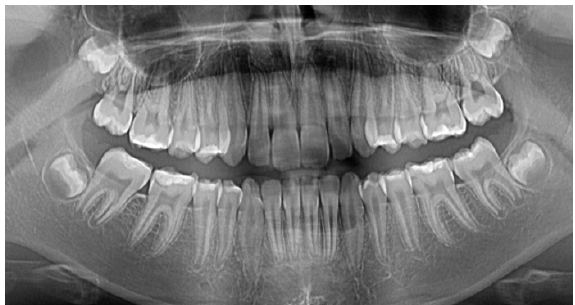
Figure 1. Orthopantomography (OPG) taken immediately after carious lesion treatment in the mandibular right first molar (MRFM).